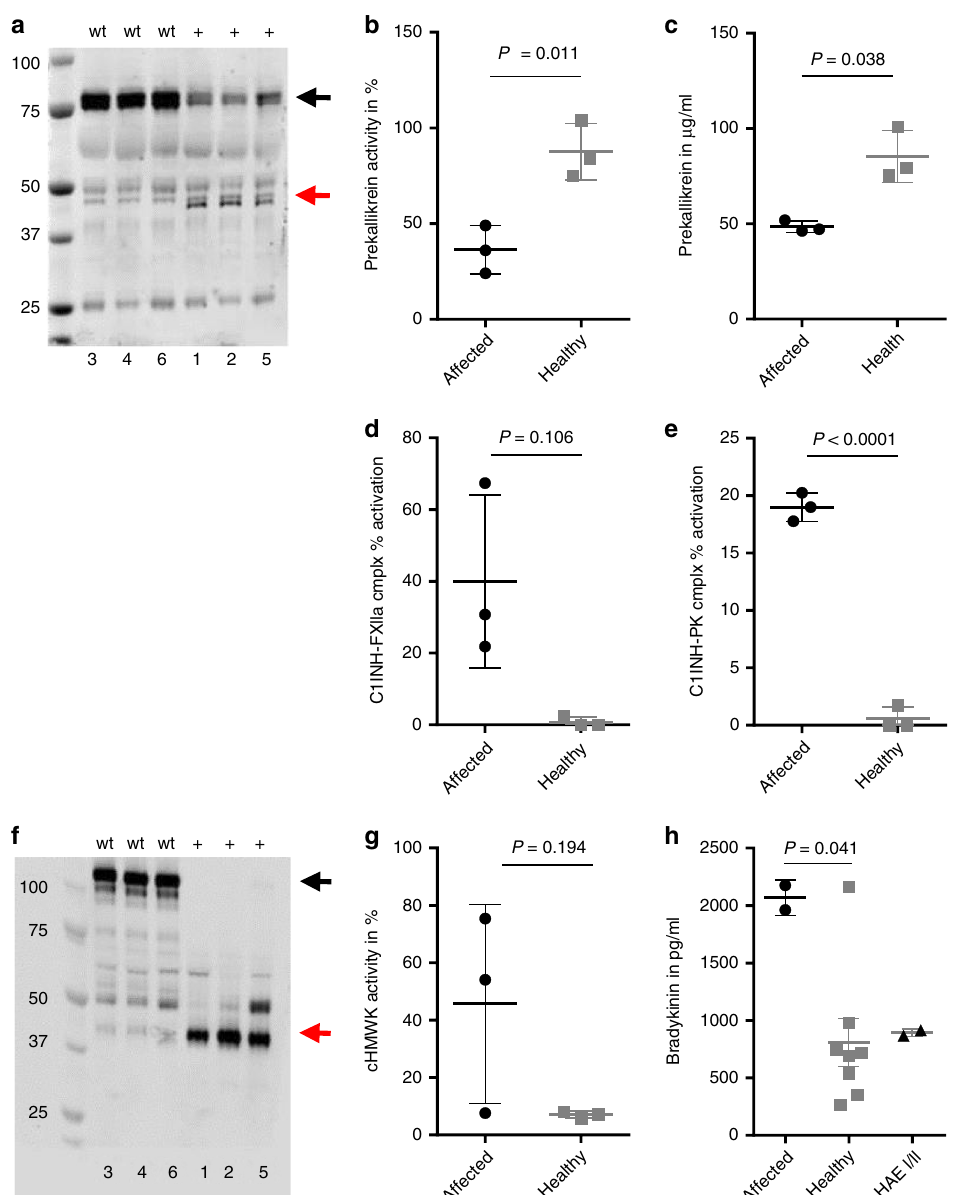
Fig. 3 FXII W268R activates the kallikrein – kinin pathway. a Citrate plasma of affected ( n = 3) and healthy family members ( n = 3) was immunoblotted for prekallikrein (PK) showing substantial cleavage of PK (black arrow) to kallikrein (red arrow), n = 2 technical replicates. This corresponds to reduced PK activity ( b ) and plasma levels ( c ) in affected individuals ( n = 3 affected vs. n = 3 healthy). d FXIIa-C1-inhibitor (FXIIa-C1-INH) and e ) PK-C1-INH complexes in patient plasma ( n = 3 affected vs. n = 3 healthy). f Citrate plasma of affected ( n = 3) and healthy family members ( n = 3) was immunoblotted for high- molecular-weight kininogen (HMWK) showing its complete degradation (black arrow) to cleaved HMWK (cHMWK) (red arrow), n = 2 technical replicates. Correspondingly, increased cHMWK activity ( g ) and bradykinin plasma levels ( h ) ( n = 3 affected vs. n = 3 healthy; n = 2 affected vs. n = 7 healthy and n = 2 HAE I/II) are detectable in the plasma of affected patients. PK and cHMWK activity were measured by chromogenic assays, PK and bradykinin plasma levels were assessed by ELISA. Graphs show individual data points and the mean ± s.e.m. Statistical signi fi cance is indicated by unpaired Student ’ s t test with Welch ’ s correction ( b , c , d , e , g ) or one-way ANOVA with Sidak ’ s multiple comparisons test ( h ). Source data are provided as a source data fi